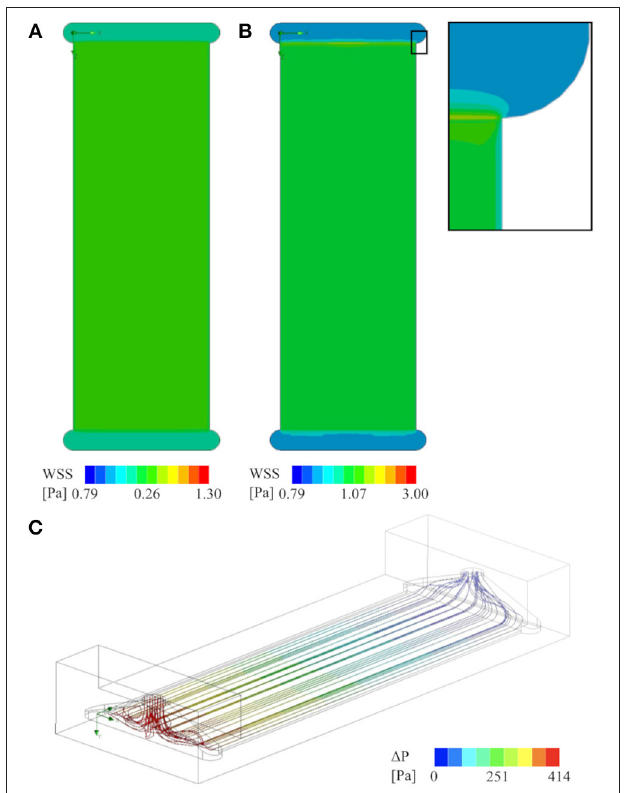
FIGURE 10 | CFD analysis of the flow chamber that was used for all experiments (cross-section of 0.3x20 mm 2 ): (A) Contour plot of WSS on the glass slide at 5 ml/min flow rate, and (B) at 20 ml/min, including a close up showing the boundary effects of the channel walls. (C) Stream lines visualizing the flow field from the inlet (red–high-pressure side) to the outlet (blue–low-pressure side) at 20 ml/min flow rate. There are no apparent zones of flow stagnation in the active area of the flow chamber.